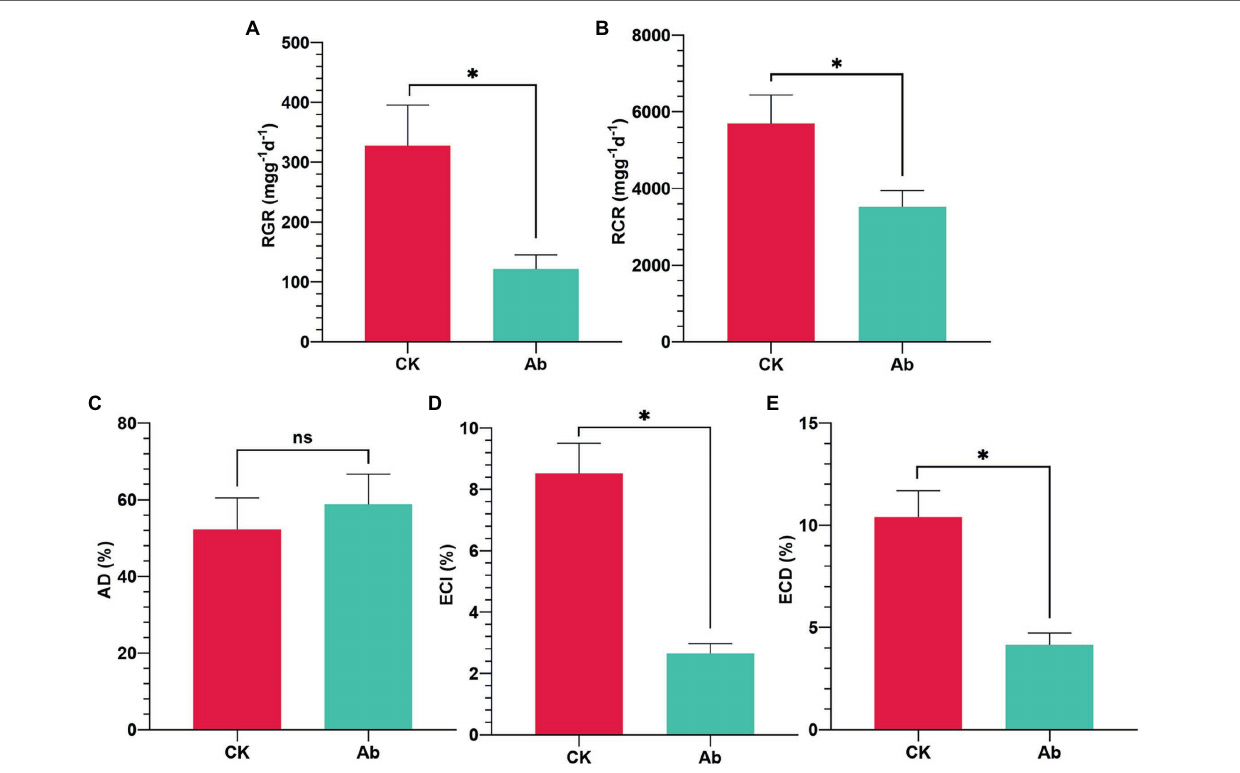
FIGURE 1 | Effect of antibiotics on food utilization indices of Cnaphalocrocis medinalis . (A) Relative growth rate of C. medinalis ; (B) Relative consumption rate of C. medinalis ; (C) Approximate digestibility of C. medinalis ; (D) Efficiency of conversion of ingested food of C. medinalis ; and (E) Efficiency of conversion of digested food of C. medinalis . Ab, Antibiotic treatment; and CK, Control. Values are mean ± SE. *Indicates significant difference at p < 0.05; ns indicates no significant difference ( p ≥